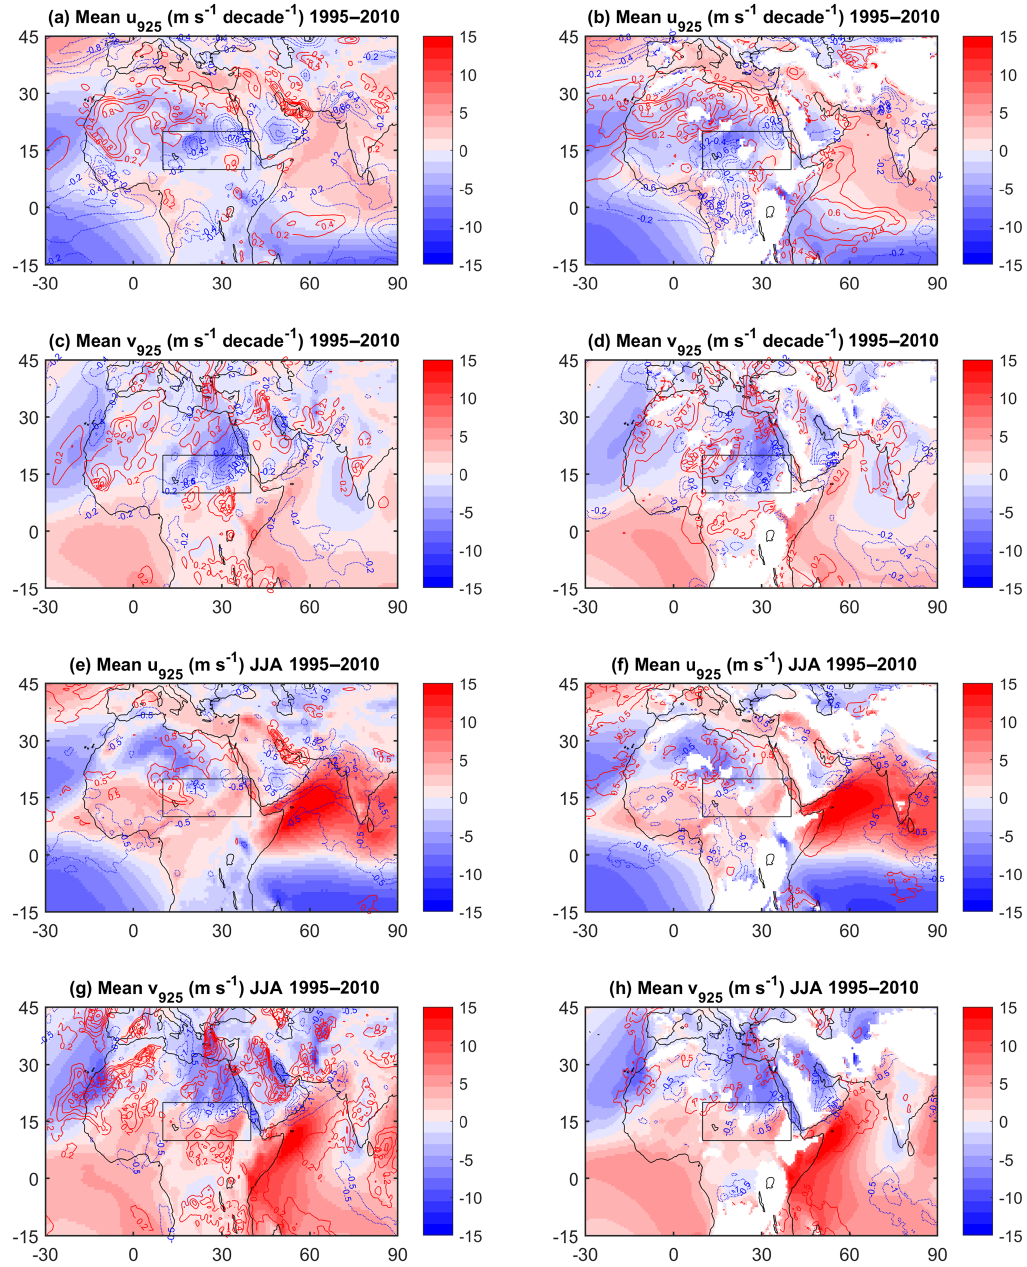
Figure 12. Close-up of northern Africa showing the mean monthly and JJA fields and trends (contours) of the u and v wind components at 925hPa (shaded). The area of focus (where IWV trends are most intense in ERA-Interim) is marked by a